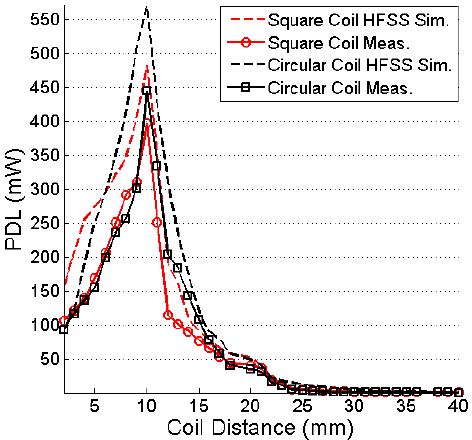
Figure 19. PDL versus coupling distance.